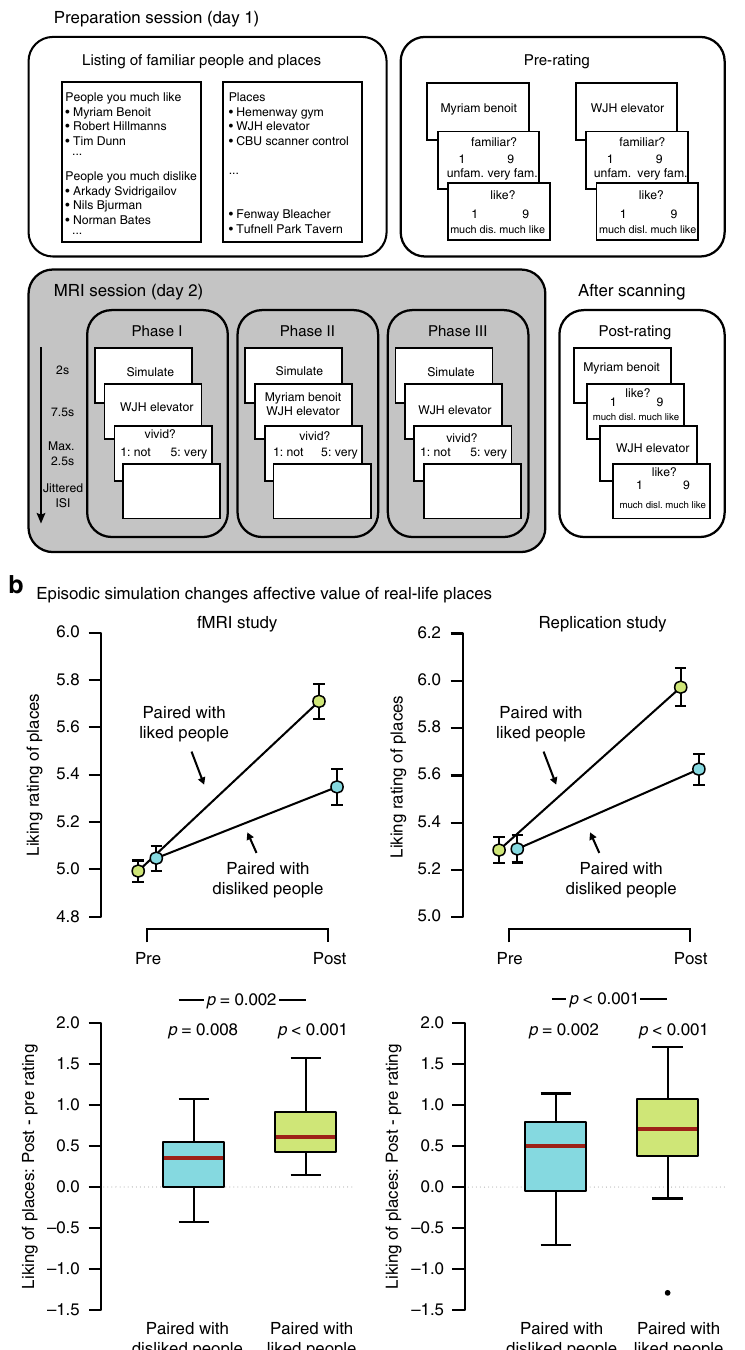
Fig. 1 Main stages of the procedure and behavioral results. a In an initial session, participants provided names of both liked and disliked people as well as of speci fi c places from their everyday environment. They then rated how much they liked the people and places (indexing value) and how familiar they are with each of those. Based on the ratings, we selected neutral places and combined each of those with either a liked or a disliked person. In a second session, participants were scanned with fMRI during three phases: In phase I, they imagined interacting with each person and place in isolation. In phase II, they were shown the critical pairings and imagined interacting with the respective person in a way that would be speci fi c to that place. Phase III was identical to phase I, except for a different presentation order. Finally, outside the scanner, participants re-rated their liking of each person and place. Moreover, they indicated, for each person – place pairing, the plausibility of such a meeting and the anticipated pleasantness. b Consistent across a fMRI study and a pre-registered replication study, we observed that places were deemed more positive following the integrative simulations. Critically, this pattern was stronger for places that had been the imaginary locations of meetings with liked than with disliked people. Episodic simulation thus induced a change in attitude of the UCS that was contingent on the valence of the CS. Error bars in the pre- versus post panels indicate the respective standard error of the mean. Boxplots indicate the median, central quartiles, and + / − 2.7SD. The dot denotes an outlier beyond that